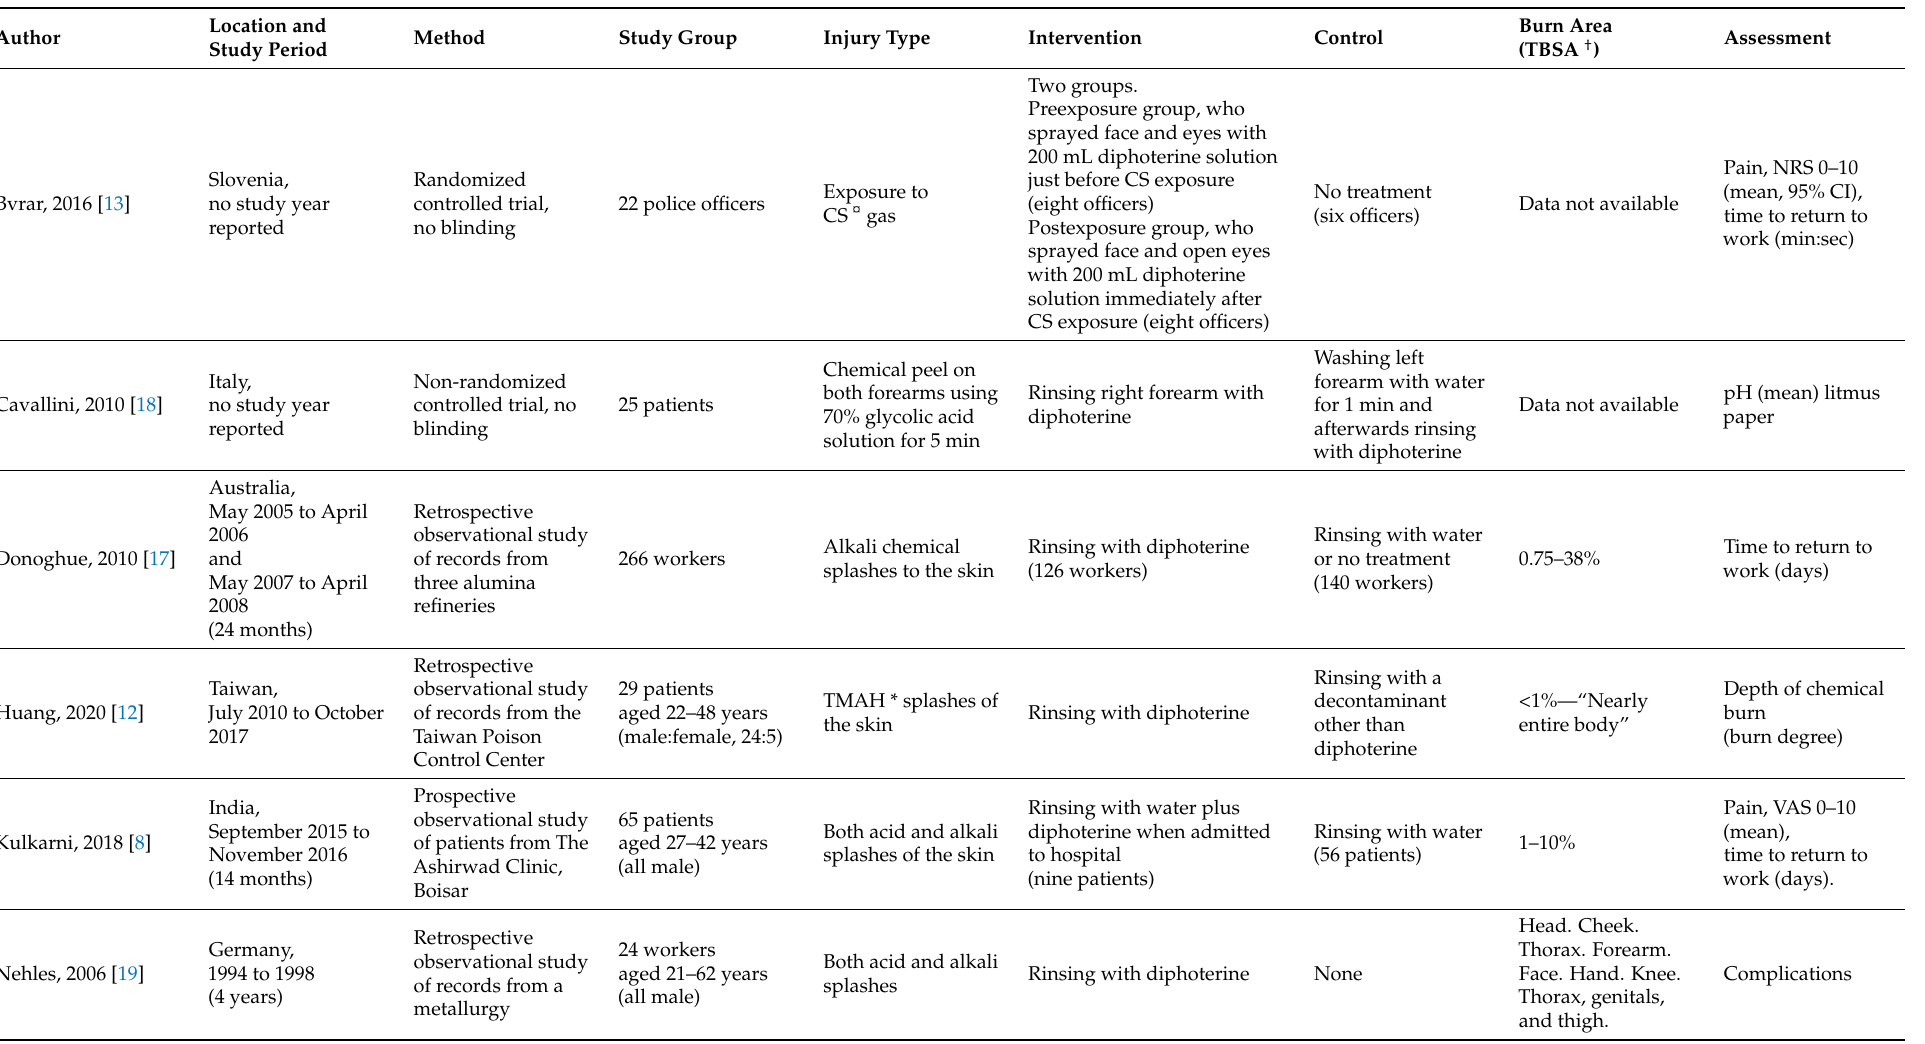
Table 1. Characteristics of the studies comparing Diphoterine with water or no treatment for chemical burns of the